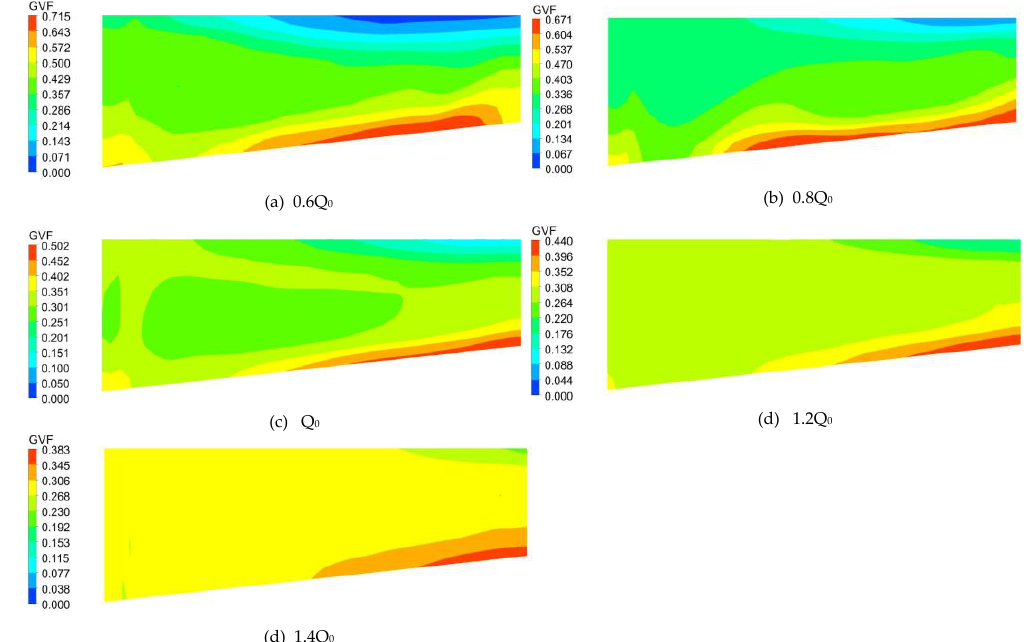
Figure 5. Gas volume fraction (GVF) distribution of the meridional surface in the impeller passage at different flow rates.